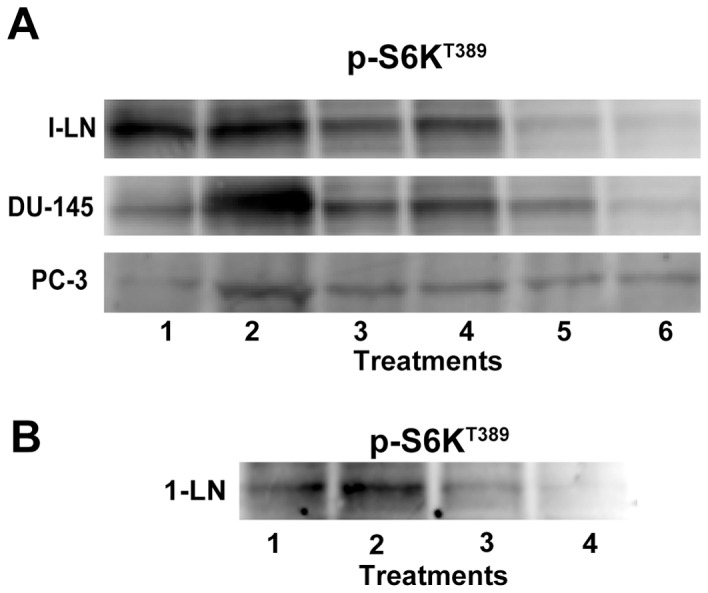
Inhibition of 8-CPT-2Me-cAMP-induced activation of p-S6-kinaseT389 in Raptor immunoprecipitates by COX-2 inhibitors (Panel A) or mTOR inhibitor Torin1 (Panel B) in prostate cancer cells.A representative immunoblot of p-S6-kinaseT389 from three independent experiments are shown in Panel A and Panel B. The immunoblot lanes in Panel A are: (1) buffer; (2) 8-CPT-2Me-cAMP (100 μM/30 min); (3) AH23848 (1 μM/3 h); (4) AH23848 then 8-CPT-2Me-cAMP (100 μM/30 min); (5) SC 58125 (1 μM/3 h) and (6) SC58125 then 8-CPT (100 μM/30 min) and the lanes in Panel B are: (1) buffer; (2) 8-CPT-2Me-cAMP (100 μM/30 min); (3) Torin1 (250 nM μM/3 h) and (4) Torin1 than 8-CPT-2Me-cAMP.